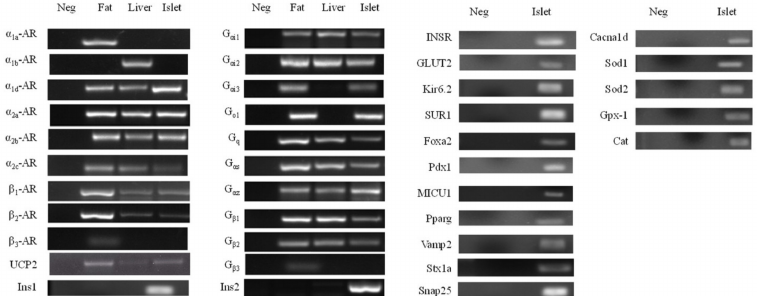
Figure 5. Genes expression of regulatory signals of insulin secretion in the islet, liver and fat tissues. Neg, negative control; AR, adrenergic receptor; G α i1-3 , G α o1 , G q , G α s , G α z and G β 1-2 , G protein subunits; UCP2 , uncoupling protein 2; Ins1 , insulin1; Ins2 , insulin2; MICU1 , mitochondrial calcium uptake 1; INSR , insulin receptor; GLUT2 , glucose transporter type 2; Kir6.2 , ATP-sensitive K + channel subunit; SUR1, sulphonylurea receptor 1; Foxa2 , forkhead box A2; Pdx1 , pancreatic and duodenal homeobox 1; MICU1 , mitochondrial calcium uptake 1; Pparg , peroxisome proliferator-activated receptor gamma; Vamp2 , vesicle-associated membrane protein 2; Snap25 , synaptosome associated protein 25; Stx1a , syntaxin 1A; Cacna1d , calcium voltage-gated channel subunit alpha1 D; Sod1 , superoxide dismutase 1; Sod2 , superoxide dismutase 2; Gpx1 , glutathione peroxidase 1; Cat ,